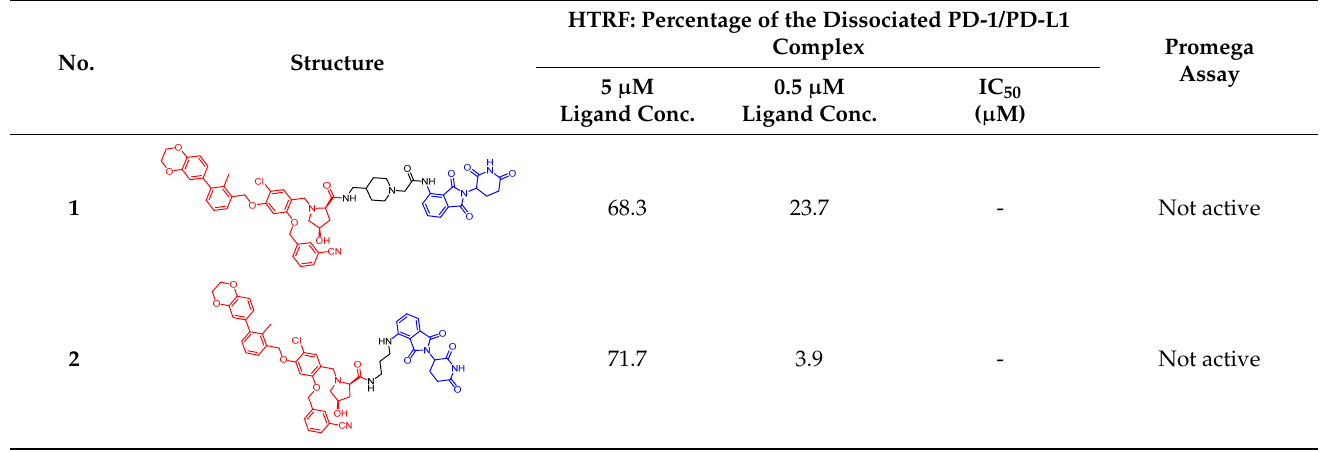
Table 1. Activities and structure of the tested chimeras. Red: PD-1/PD-L1 inhibitor, black: linker, blue: pomalidomide.